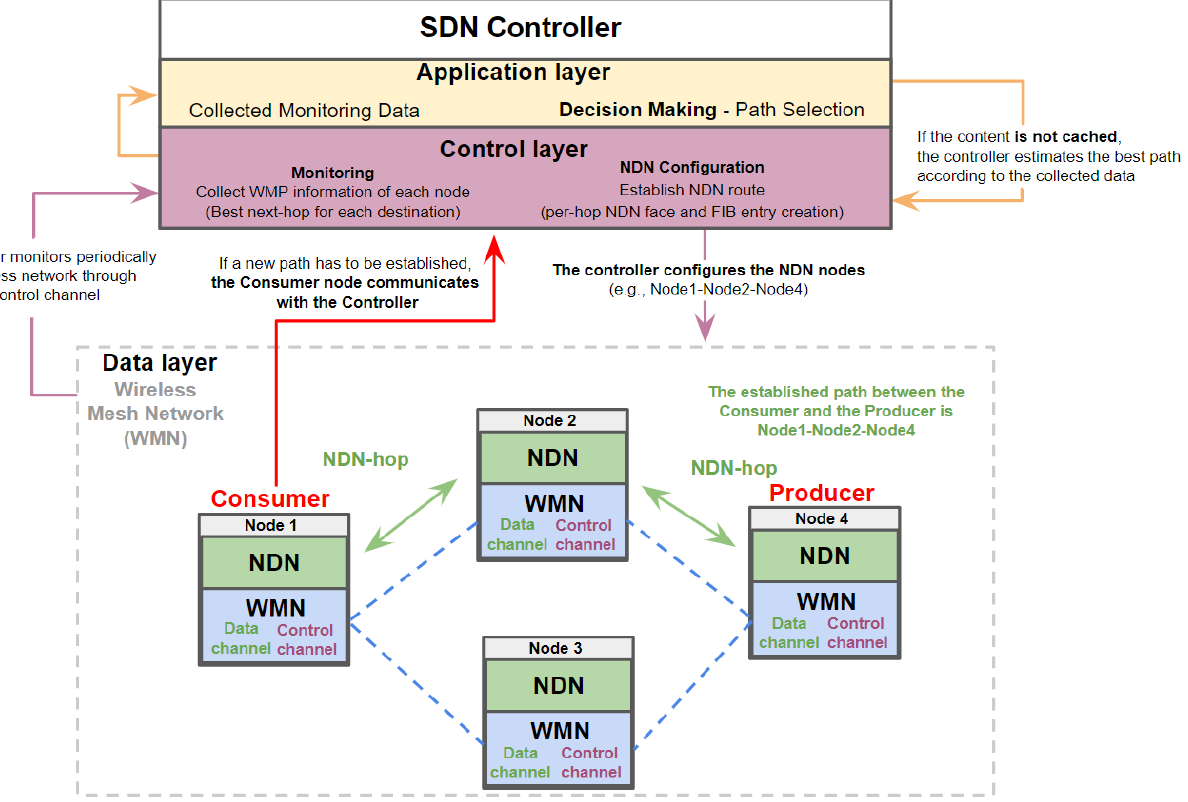
Figure 2. SDN-based Experimentation